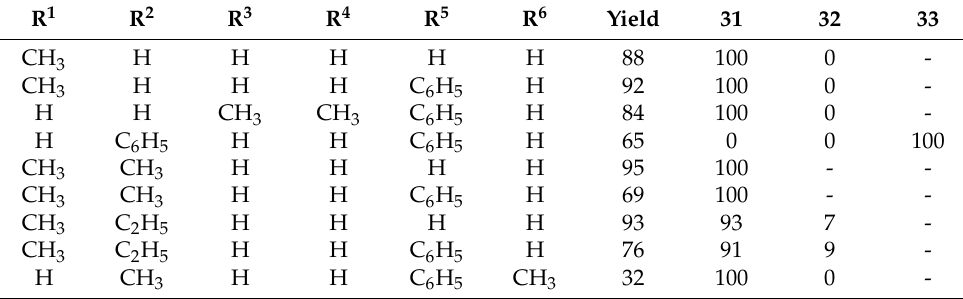
Table 2. Interaction of substituted ethylenediamines with maleimides.